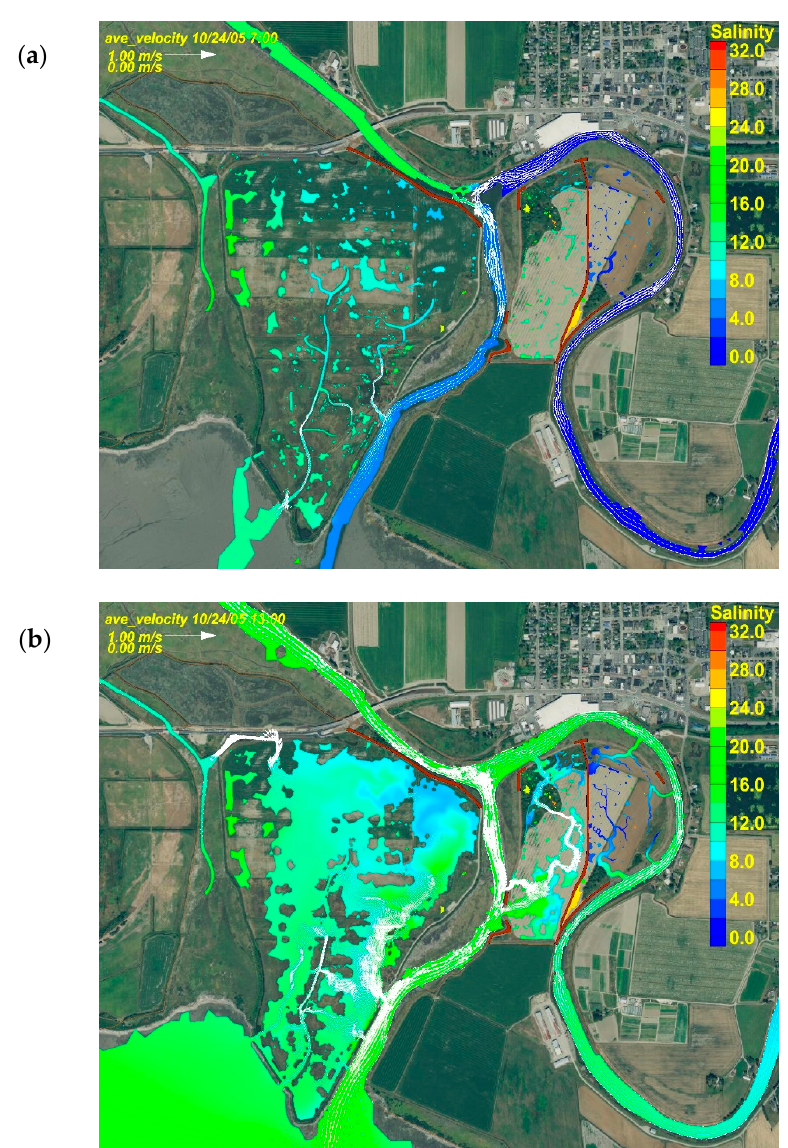
Figure 12. Horizontal distribution of salinity at low tide (07:00: a ) and high tide (13:00: b ) for the preferred restoration alternative scenario on 24 October 2005.